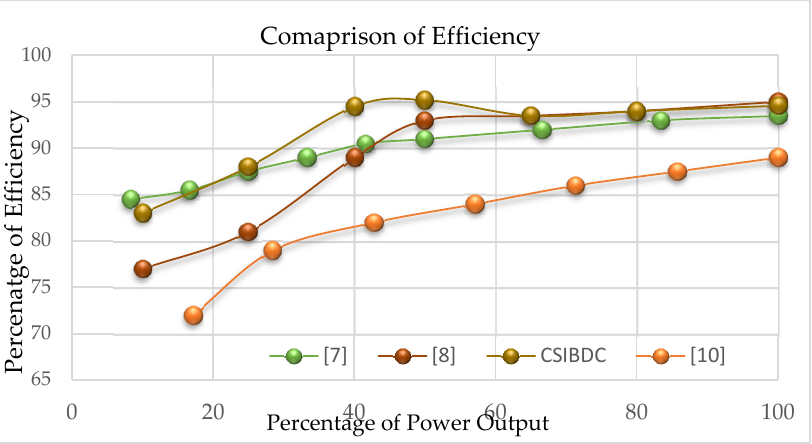
Figure 16. Comparison of efficiencies of various dual active bridge converters with CFIBDC converter. Table 4. Comparison of efficiencies of different topologies with proposed current-fed isolated bidi- rectional DC–DC converter (CFIBDC) (Percentage of output power (% of P o ) Vs. Efficiency of To- pologies given with reference number).